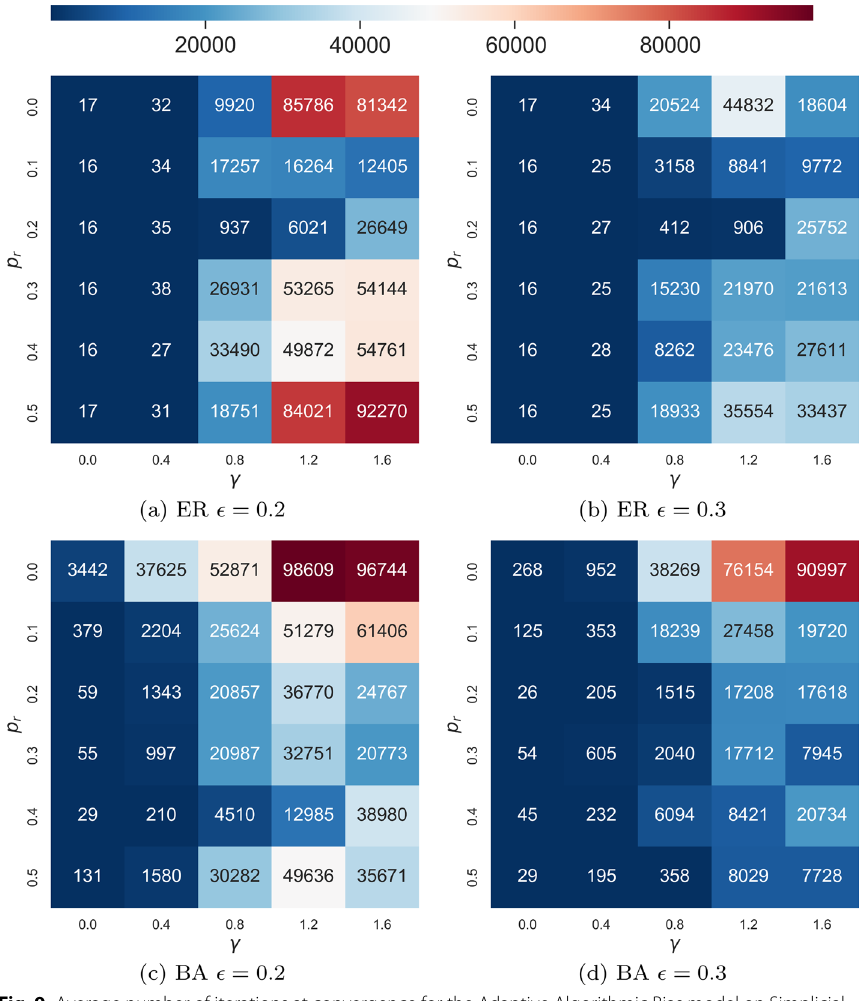
with many agents scattered across the opinion space. Moreover, such a cluster does not necessarily form around the mean opinion but can be pretty extreme (with the 1.2 , the population becomes polar- final consensus below 0.2 or above 0.7). For γ = ized: two homogeneous and opposed clusters form, and, in some cases, there are few “outlier” agents around the mean opinion or further at the extremes. Finally, for γ = 1.6 , the population splits into multiple clusters: still, in most cases, two major polarized clusters form, alongside a variety of minor clusters below, between, and above the two. Two cohesive groups coexist with a population of individuals scattered across the opinion space so that the final distribution is not so different from the ini- tial one: multiple opinions are still present in the population and cover the whole range [0,1]. Raising p r to 0.1 prevents fragmentation, but for strong biases the popula- 0.2 tion polarizes. For p r ≥ consensus is always reached. However, as in the baseline